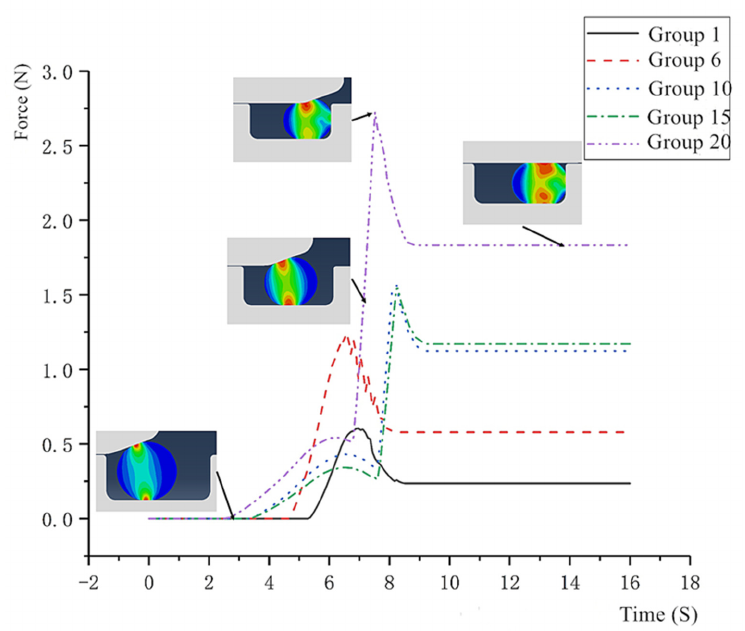
Figure 5. Changes of resistance during movement. (The force shown is the resistance of the cylinder’s motion in the axisymmetric model. The direction of the force is opposite to the direction of the cylinder’s motion. Here, the force is numerically equal to the resistance that pushes the piston into the cylinder. The purpose of this is to simplify the setting of boundary